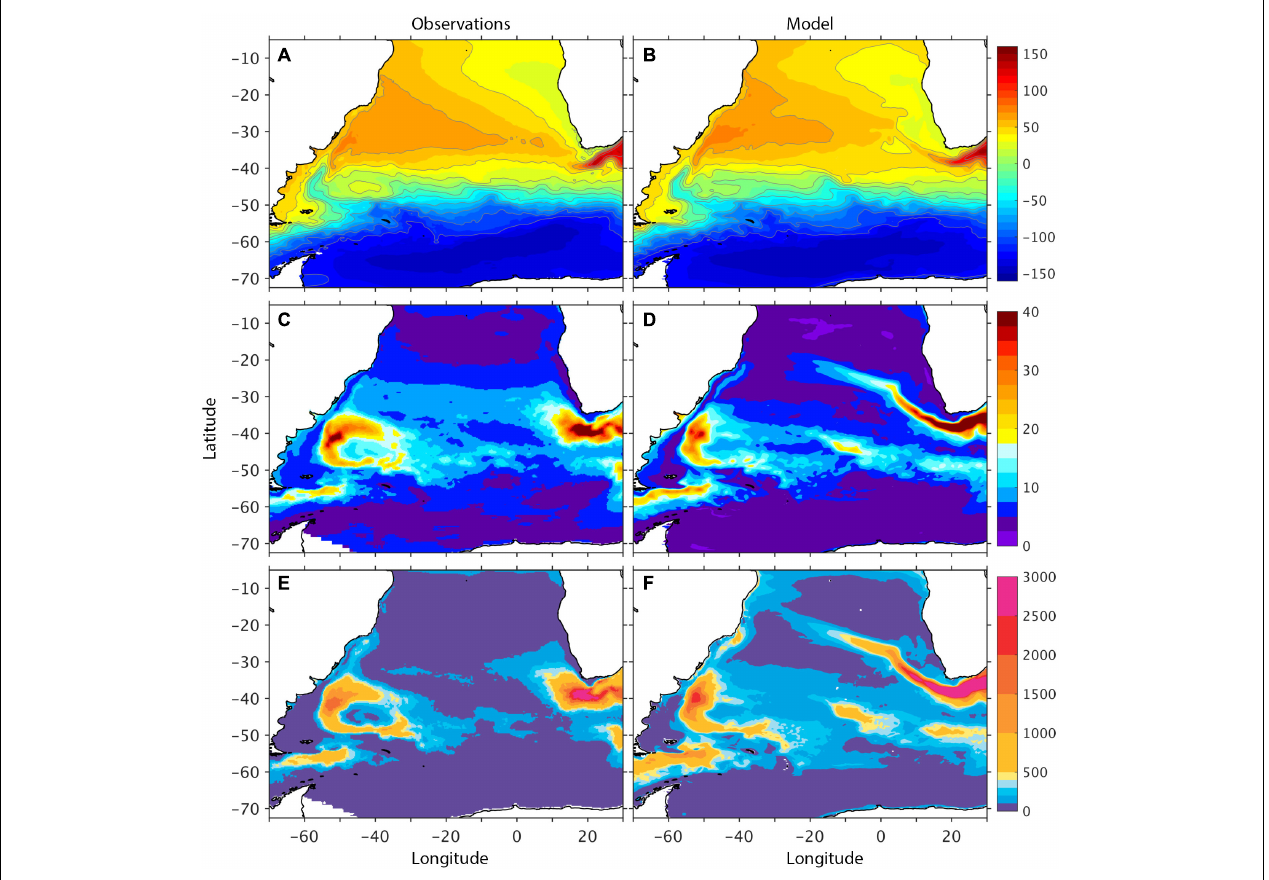
FIGURE 2 | Observed and modeled distributions of (A,B) time mean sea surface height (SSH, in cm), (C,D) SSH standard deviation (in cm), and (E,F) eddy kinetic energy (EKE, in cm 2 s − 2 ) of the surface current in the southern Atlantic. In observation, the mean SSH is based on long-term climatology CNES-CLS18 (Mulet et al., 2021); the SSH standard deviation and EKE are based on AVISO data in 1993–2018. All model results are also in